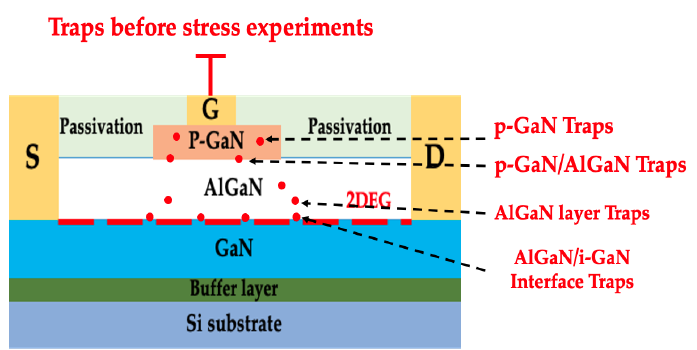
Figure 8. Schematic cross section of p-GaN HEMT device with traps in fresh device before stress